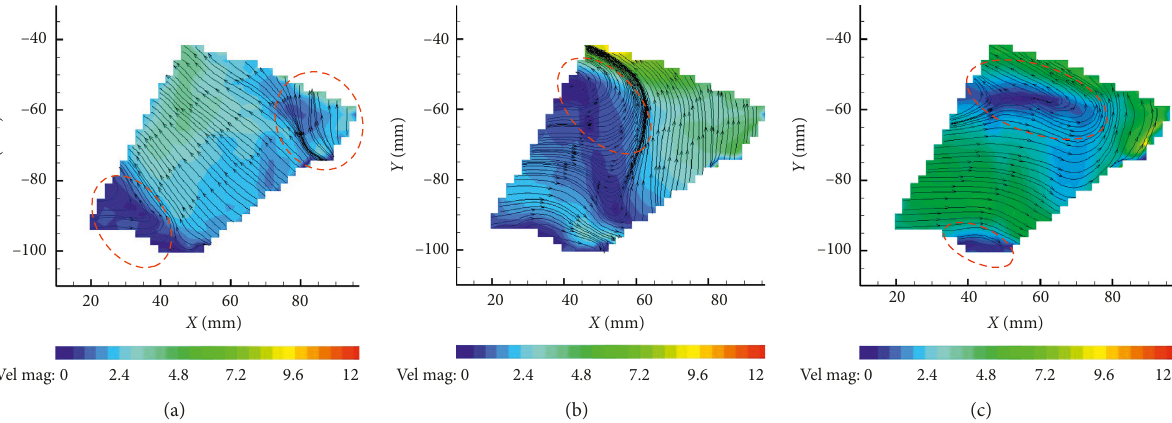
Figure 7: Streamline distribution of shooting section under different flow rate conditions. (a) 1.0 Q